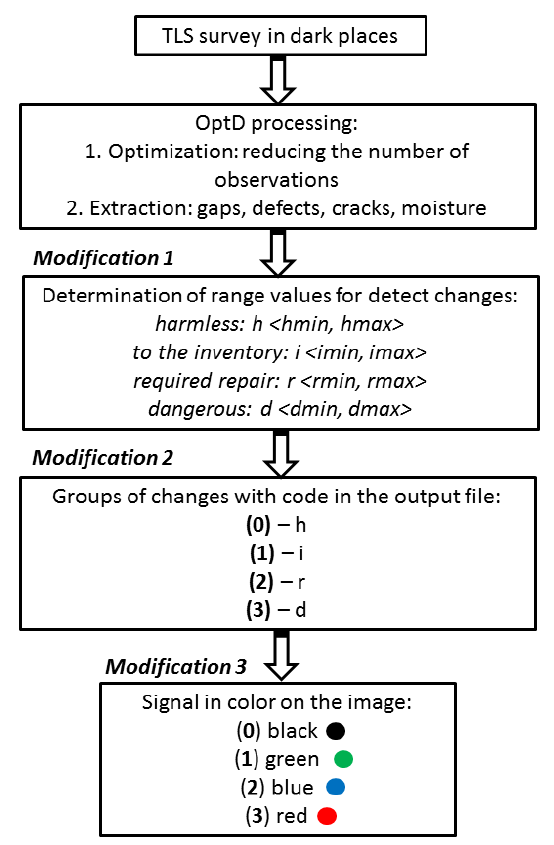
Figure 1. Introduced